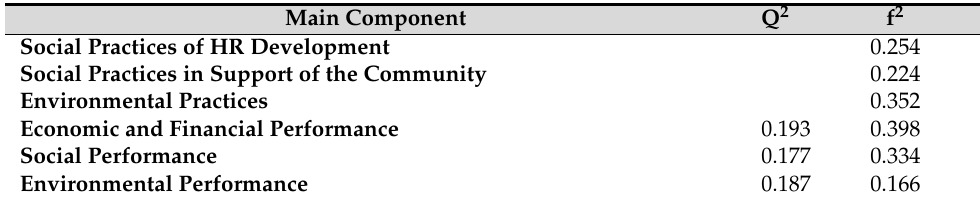
Table 12. Relevance or Predictive Validity (Q 2 ) and Effect Size (f 2